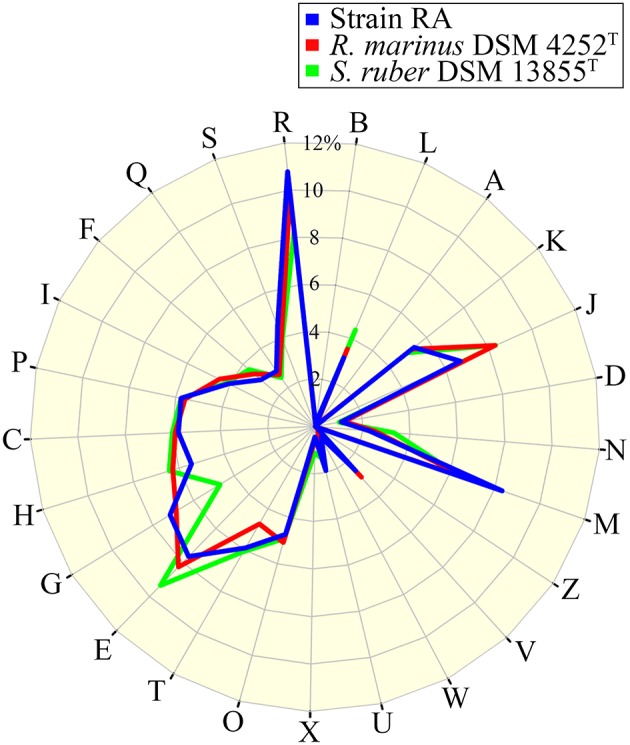
Percentage of CDS involved in COG classifications for strain RA, R. marinus DSM 4252T and S. ruber DSM 13855T. B, Chromatin structure and dynamics; L, replication, recombination, and repair; A, RNA processing and modification; K, transcription; J, translation, ribosomal structure, and biogenesis; D, cell cycle control, cell division, chromosome partitioning; N, cell motility; M, cell wall/membrane/envelope biogenesis; Z, cytoskeleton; V, defense mechanisms; W, extracellular structures; U, intracellular trafficking, secretion, and vesicular transport; X, mobilome, prophages, transposons; O, post-translational modification, protein turnover, chaperones; T, Signal transduction mechanisms; E, amino acid transport and metabolism; G, carbohydrate transport and metabolism; H, coenzyme transport and metabolism; C, energy production and conversion; P, inorganic ion transport and metabolism; I, lipid transport and metabolism; F, nucleotide transport and metabolism; Q, secondary metabolites biosynthesis, transport and catabolism; S, function unknown; and R, general function prediction only (https://figshare.com/s/8a2ccd9f2b7aa439f040).